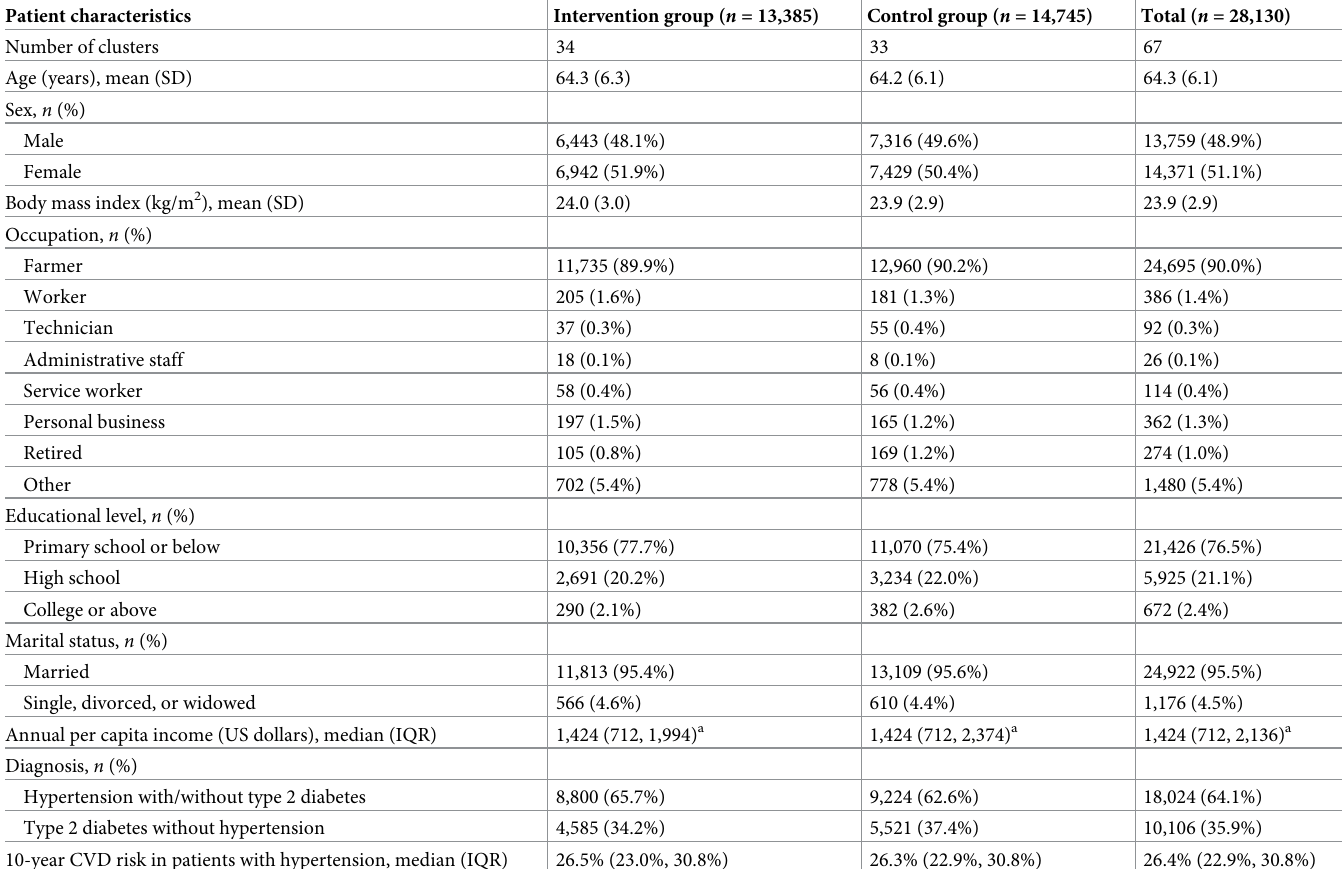
Table 2. Characteristics of the 28,130 participants in the